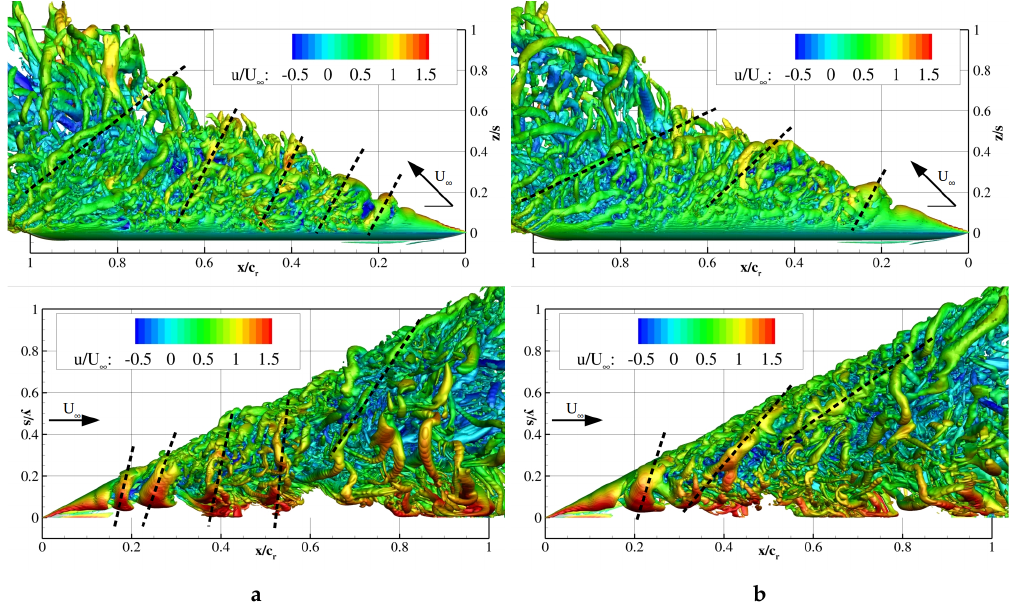
Figure 18. Q-criterion Q = 10 5 s − 2 at α = 45 ◦ ( a ) when the jets are switched off and ( b ) T /4 after